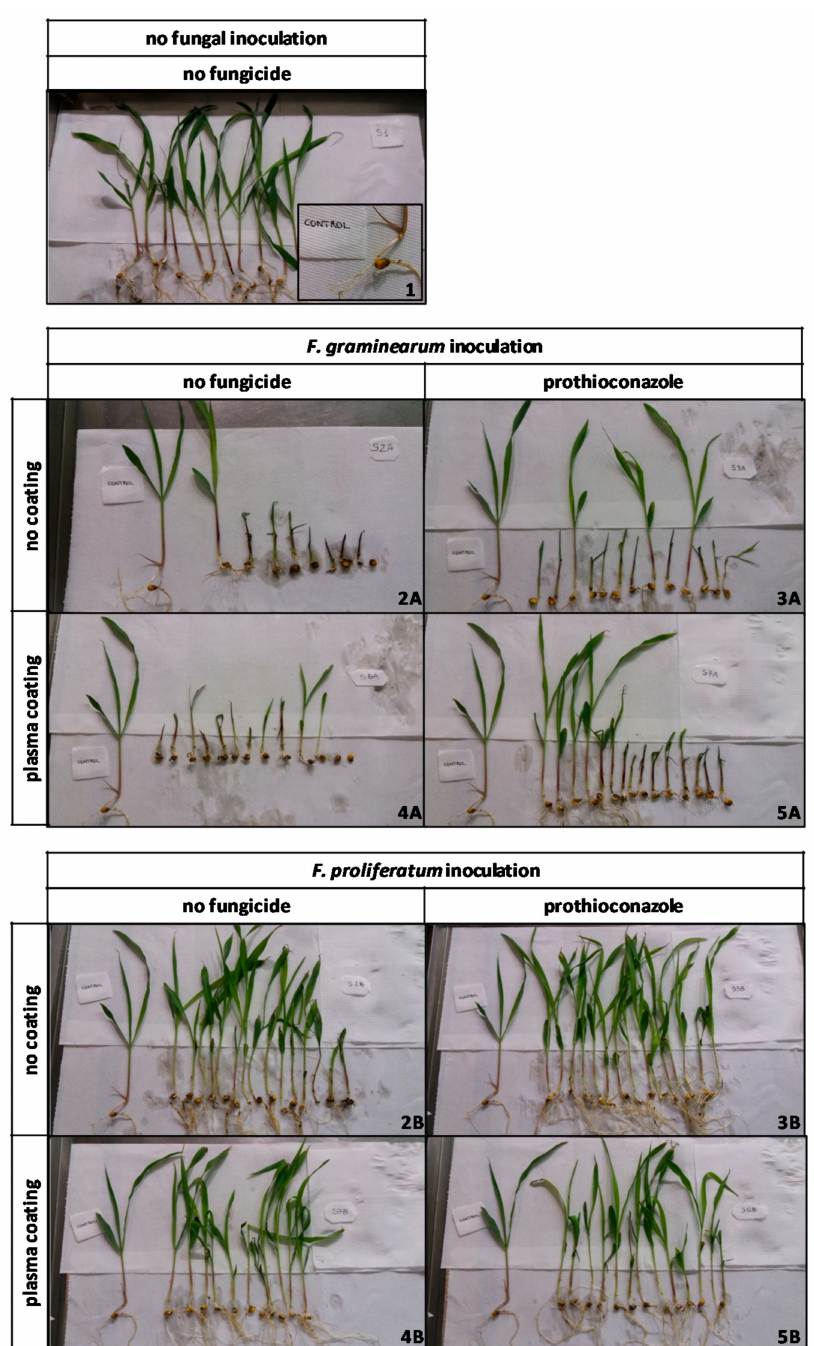
Figure 4. Ten-day-old maize seedlings, unrooted after growing in phytotron. The theses number, rep- resenting the different combined treatments, are reported at bottom right of each picture, compared to the control thesis, untreated and not inoculated with Fusarium